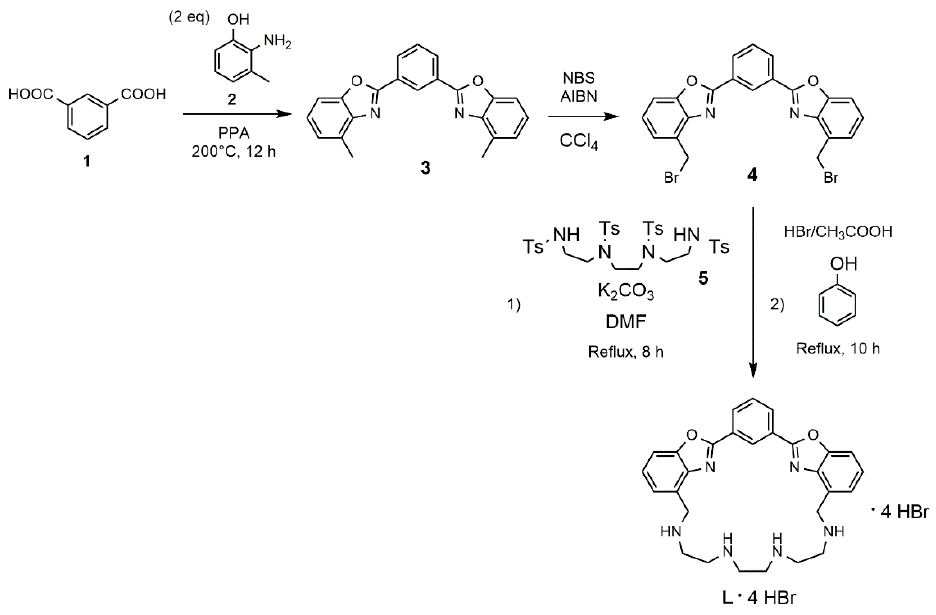
Scheme 1. Synthetic pathway of ligand L .